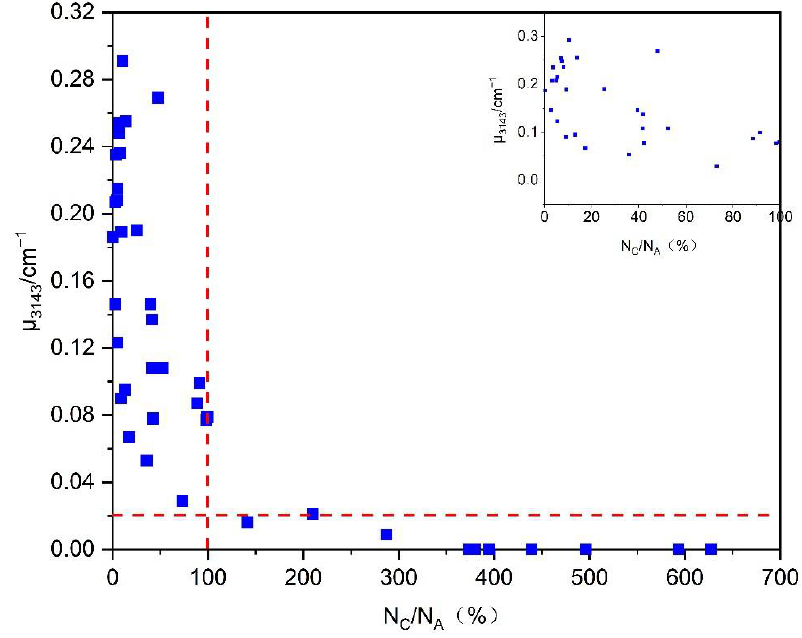
Figure 5. When the ratio of N C /N A is less than 1 (the left areas of the vertical dash line), the 3143 cm −1 absorption is more prominent. When the ratio of N C /N A is greater than 3, the 3143 cm −1 absorption coefficient is less than 0.05 cm −1 (below the horizontal dash line).